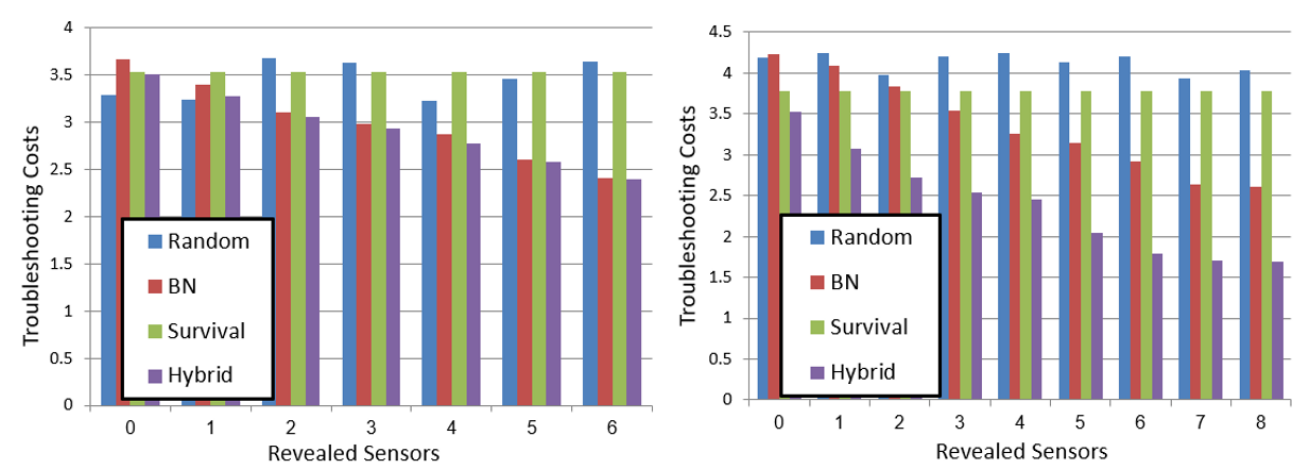
Figure 5. Diagnosis experiments’ results, for S 1 ( left ) and S 2 ( right ). Troubleshooting cost for revealed